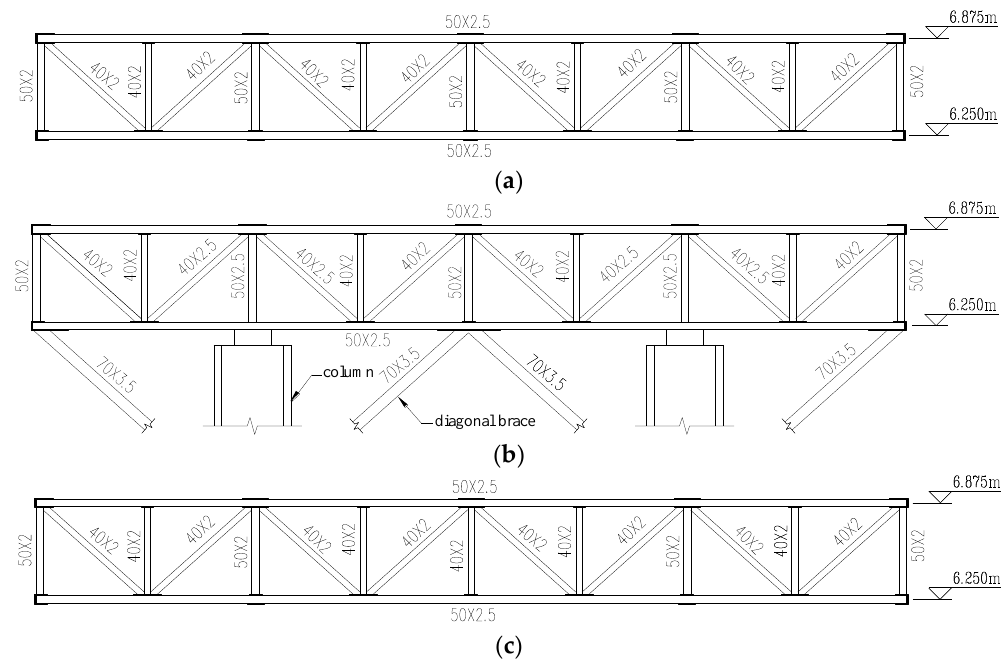
Figure 5. Cross sections of members in steel truss (unit: mm): ( a ) Elevation view of plane trusses in ○ 1 , ○ 5 , ○ A , ○ E axises; ( b ) Elevation view of plane trusses in ○ 2 , ○ 4 , ○ B , ○ D axises; ( c ) Elevation view of plane trusses in ○ 3 , ○ C axises (The axises were designated in Figure 3).